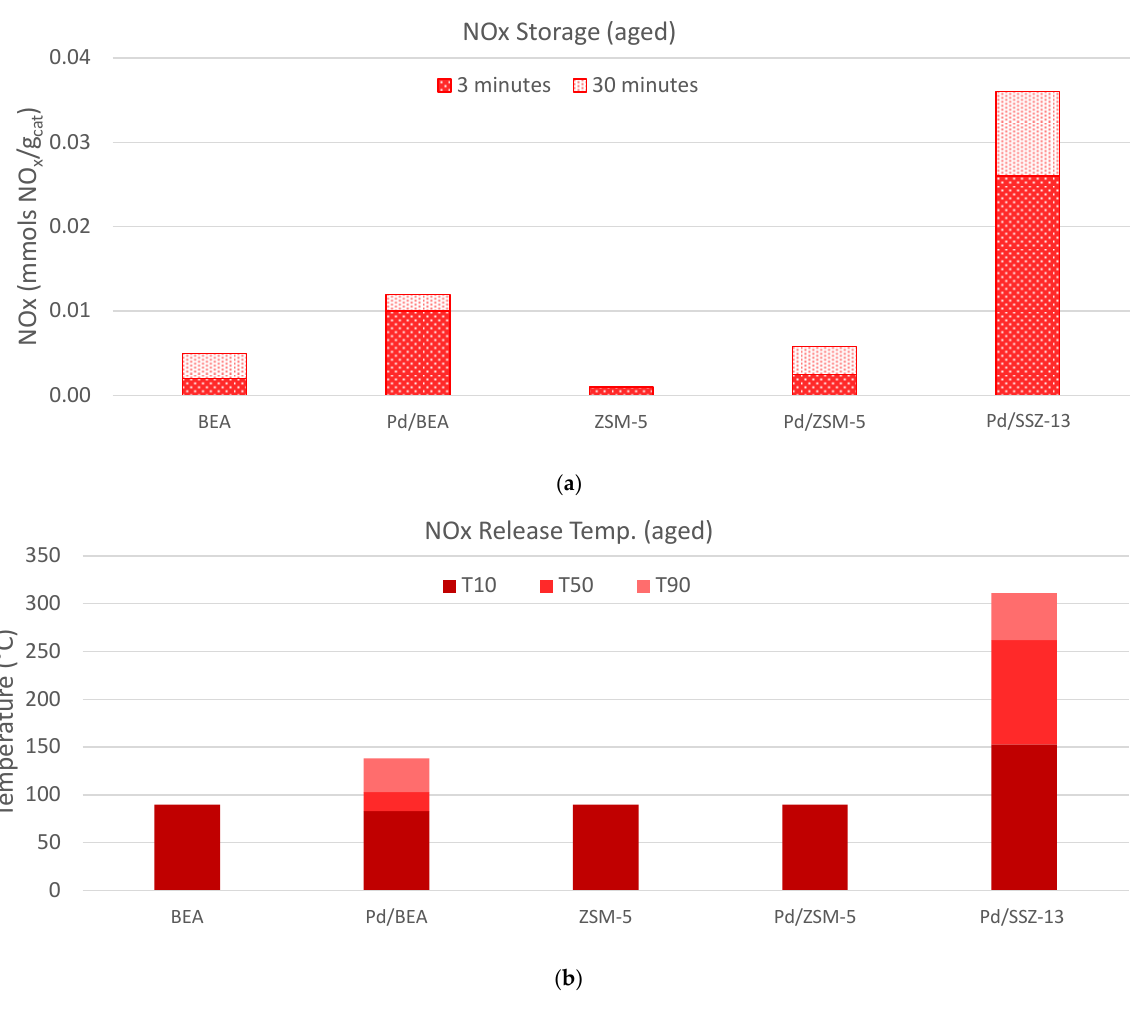
Figure 7. Following hydrothermal aging at 800 °C for 50 h ( a ) NOx adsorption after 3 ( ) and 30 ( ) minutes for each of the materials studied, and ( b ) the temperature where 10% (T10, ■ ), 50% (T50, ■ ), or 90% (T90, ■ ) of the NOx is released. Table 4. NOx storage values (mmol/g cat ) for hydrothermally aged samples. The total amount of observed NOx released during the first 15 min of the ramp, and the temperature where 10% (T10), 50% (T50), or 90% (T90) of NOx is released is also shown.